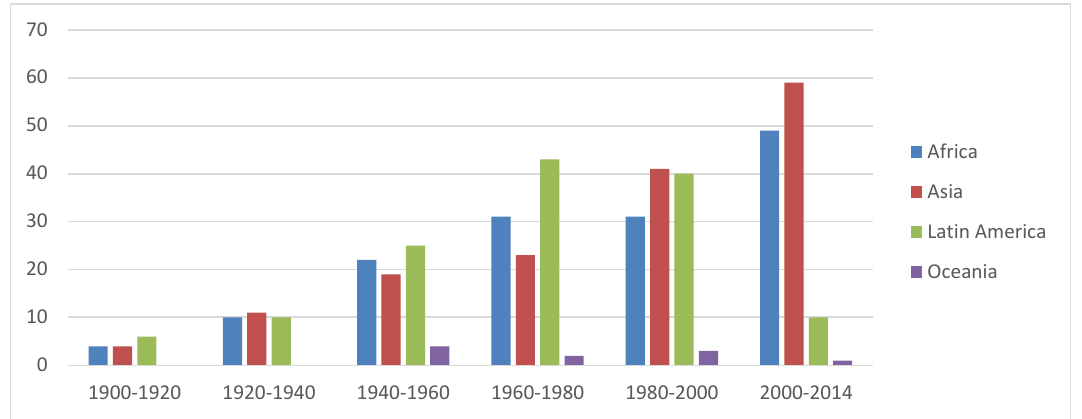
Figure 1. New foundations 1990–2014. Martin Ney, 2000, Geraldo Gonzales y Lima, AIM, 2014.